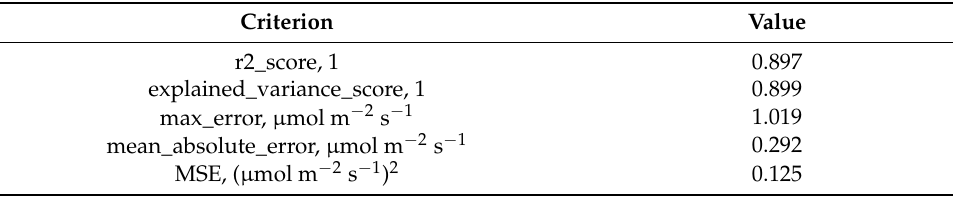
Table 3. The results of experiment 3.